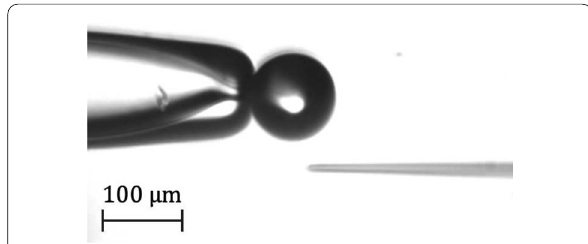
Fig. 13 2D image displayed subjects during the condition (a), (c), and (d)